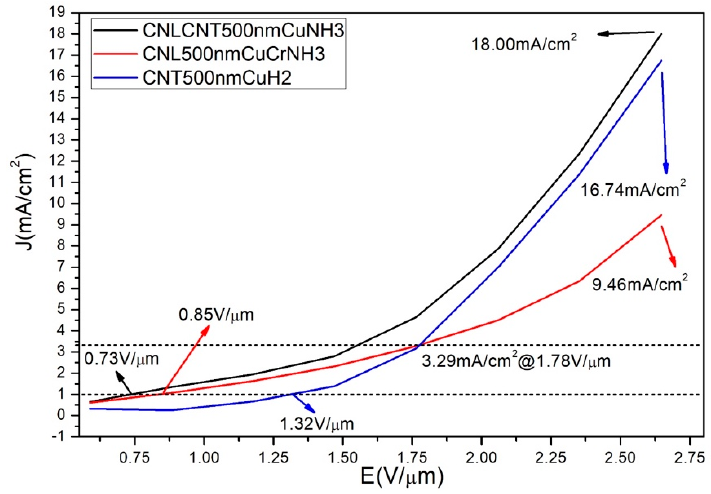
Figure 7. Field emission (FE) performance of different CNS.